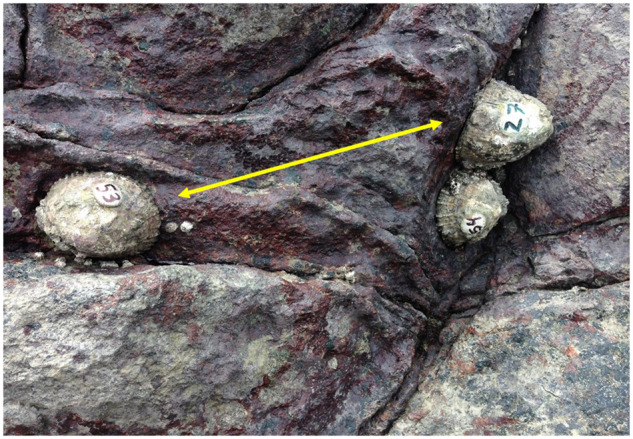
Change in social status involving a pair and a nearby solitary limpet. The limpets marked 53 and 54 were initially paired, and Limpet 27 was initially solitary. This photo shows all limpets sitting on their new home scars after Limpets 27 and 53 switched locations as indicated by the arrow. Photograph by J. Schaefer.